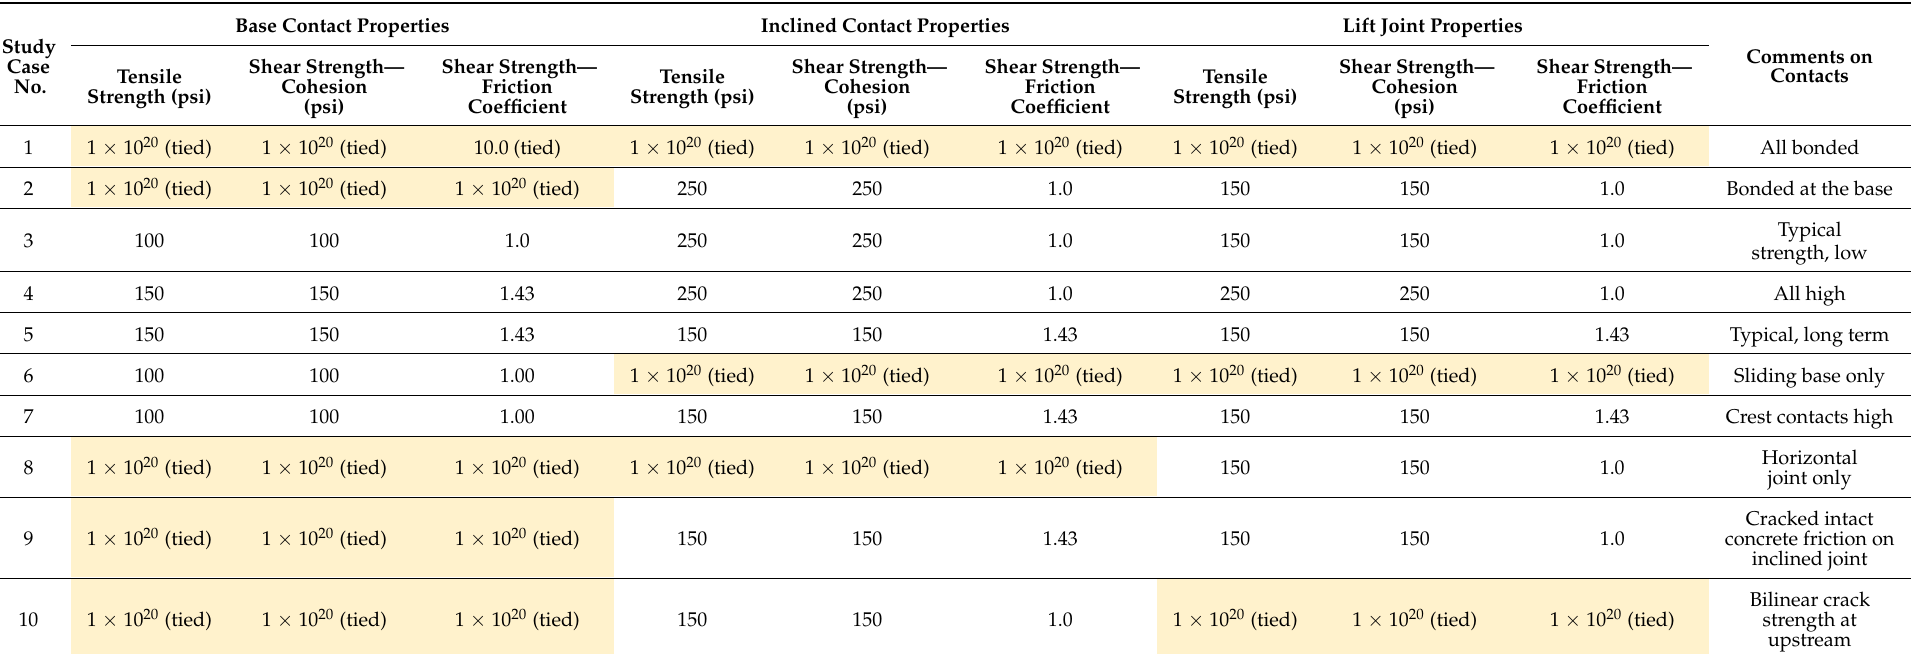
Table A2. Study cases of contact element strengths for 2D structural model